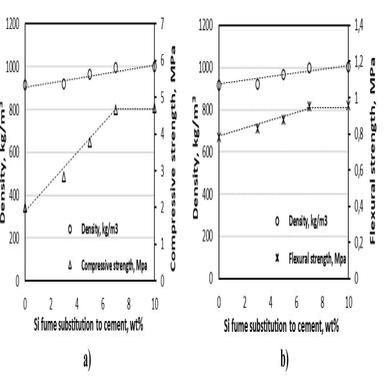
Density values and mechanical properties: a) compressive strength, b) Flexural strength of geopolymer pastes in function of different % Si fume substitutions to cement at S/L: 3.5 g/mL, 8 M KOH, 0.15 % Al powder & 70 ◦C curing temperature.